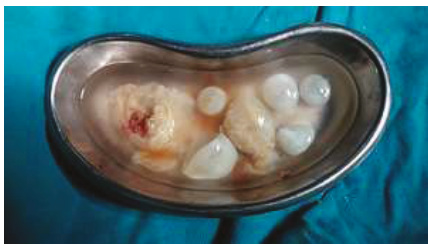
Figure 3: Specimen showing multiple daughter